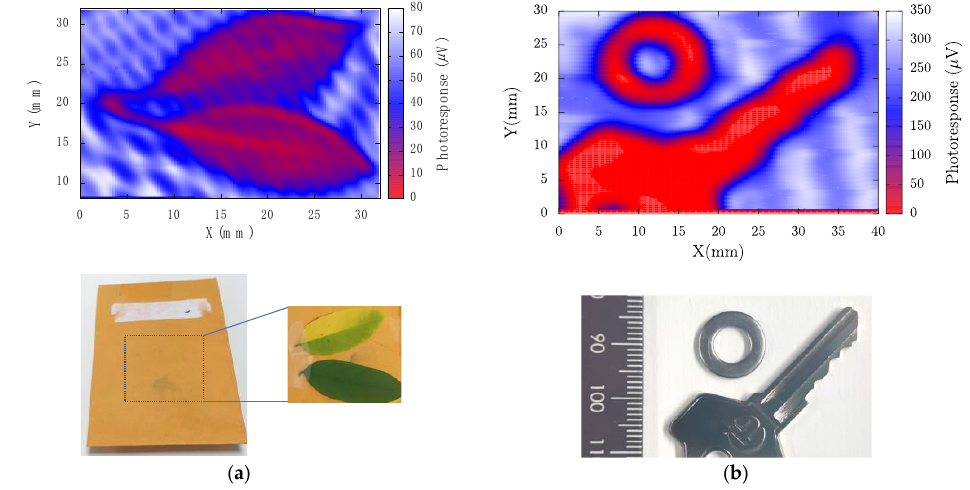
Figure 11. ( a ) 300 GHz image of two leaves inside an envelope and, below, photograph of the envelope showing the position of the leaves; ( b ) 300 GHz image of two metallic objects inside an envelope and, below, photograph of the